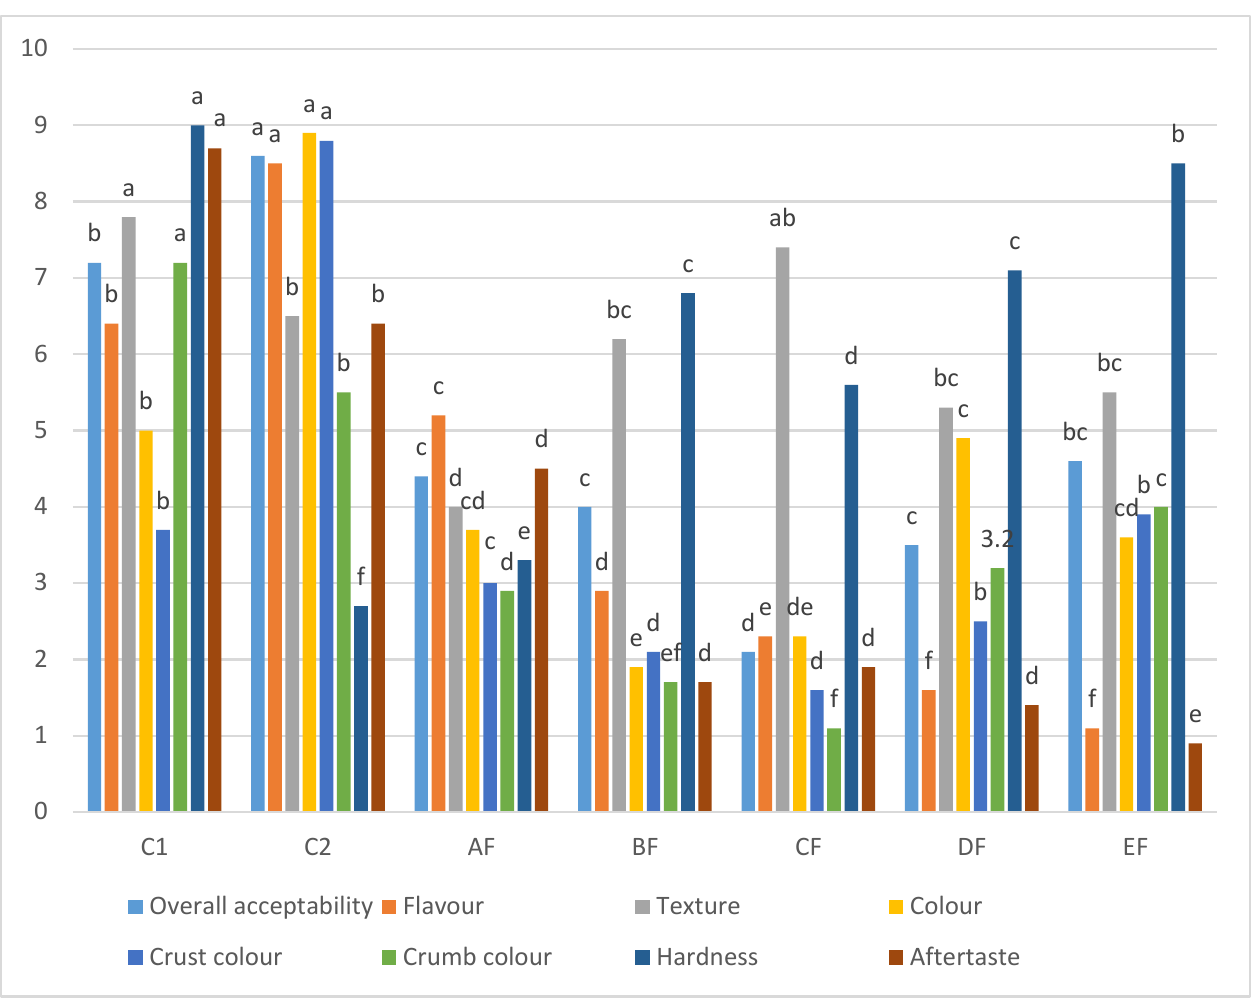
Figure 3. Sensory Attributes of Gluten Free Doughnuts: AF (15%), BF (30%), CF (45%), DF (60%) and EF (75%) lupin flour: potato starch and corn flour composite, (C1) based on wheat flour; (C2) based on potato starch and corn flour composite. Different letters for different treatments mean they are significantly different ( p ≤ 0.05) b ased on Duncan ’ s multiple range test.